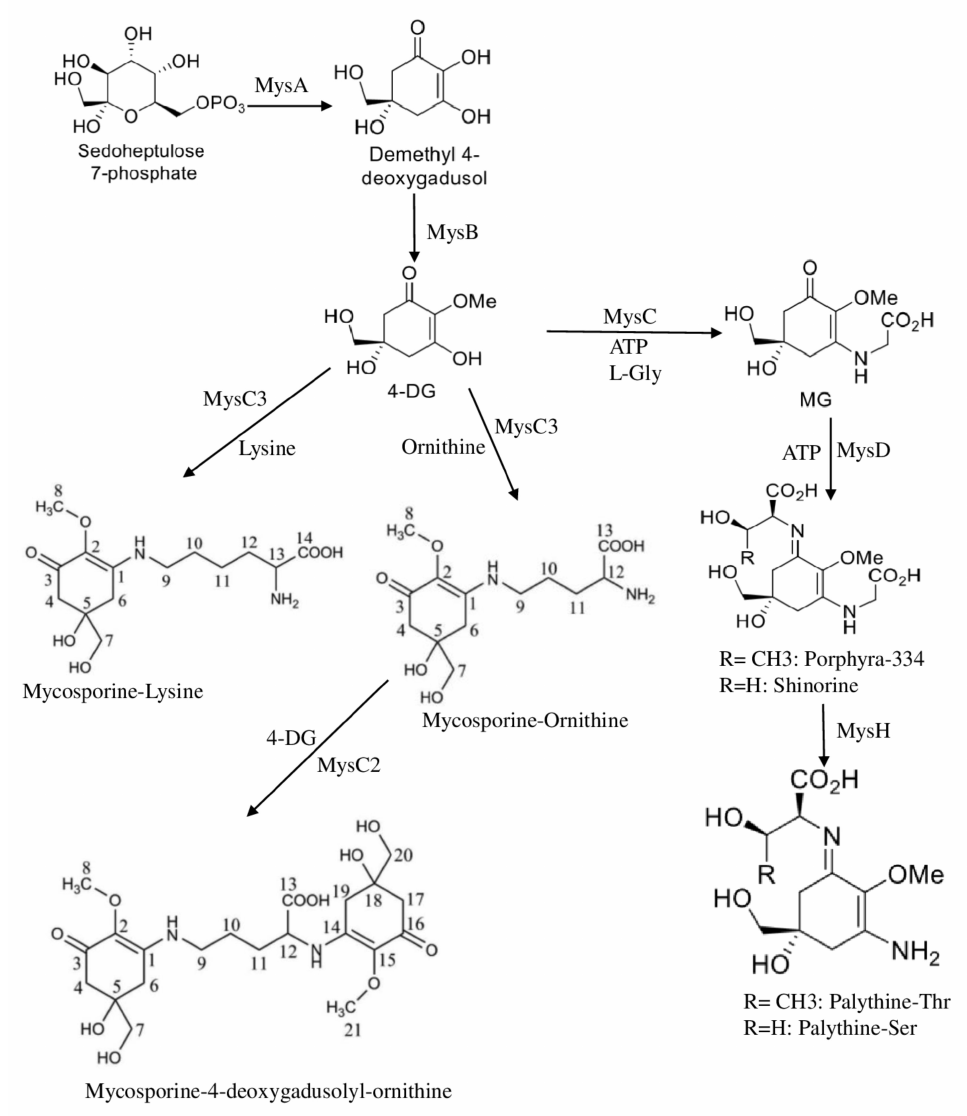
Figure 1. Biosynthesis pathway for the MAAs. 4-DG (4-deoxygadusol), MG (mycosporine–glycine). mysA (dimethyl 4-degadusol synthase), mysB (O-methyltransferase), mysC (ATP-grasp ligase), mysD (D-Ala–D-Ala ligase), mysH (dehydrogenase/reductase and a nonheme iron(II)- and 2-oxoglutarate- dependent